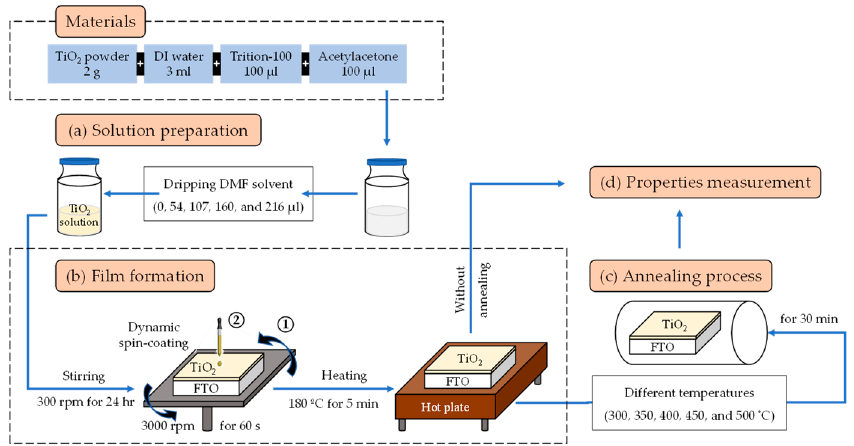
Figure 1. The schematic diagram of TiO 2 preparation, including ( a ) solution preparation injected at different DMF doses from 0 to 10 wt%, ( b ) film formation onto the hotplate, ( c ) annealing process at different temperatures from 300 to 500 °C, and ( d ) properties measurement.